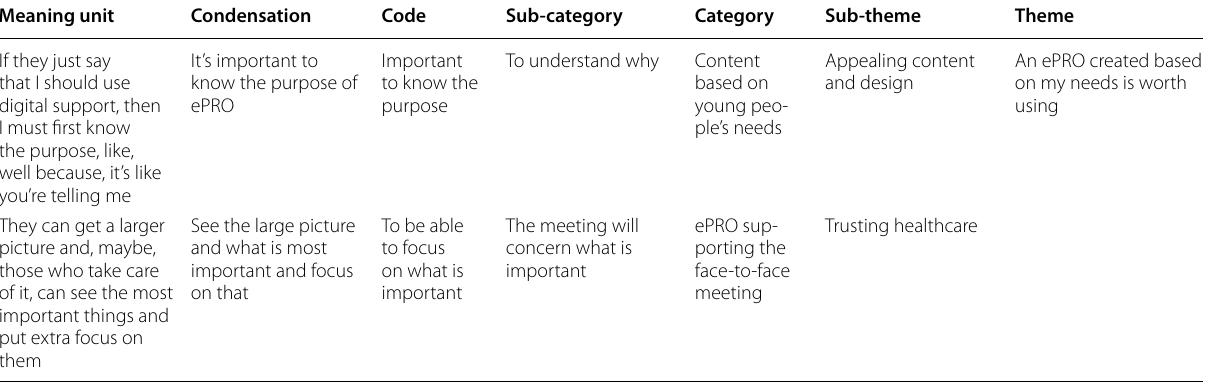
ePRO electronic patient-reported